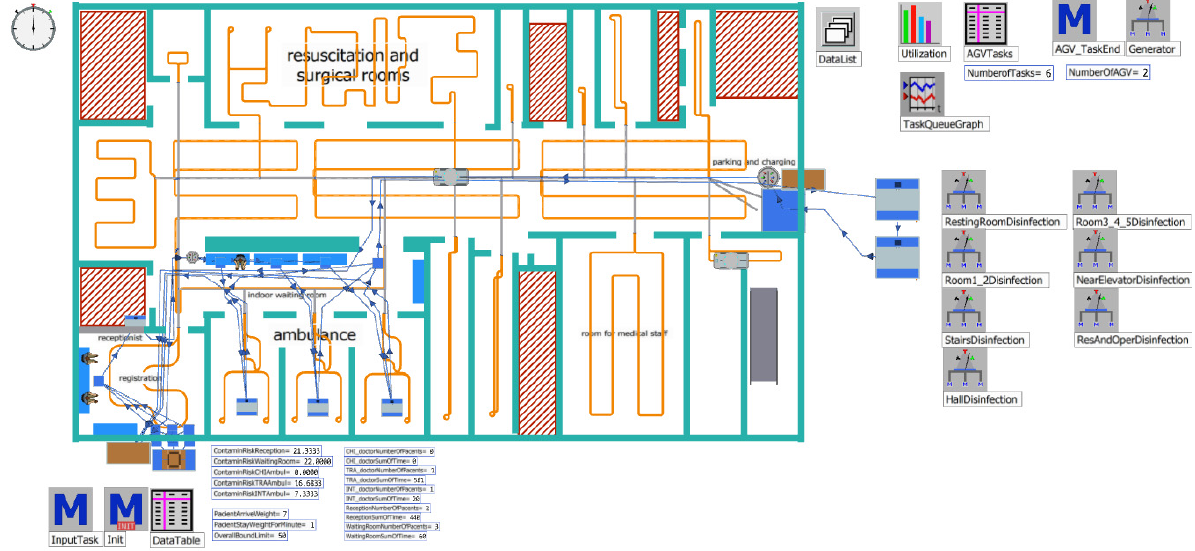
Figure 13. Creating a simulation model designed for experiments.